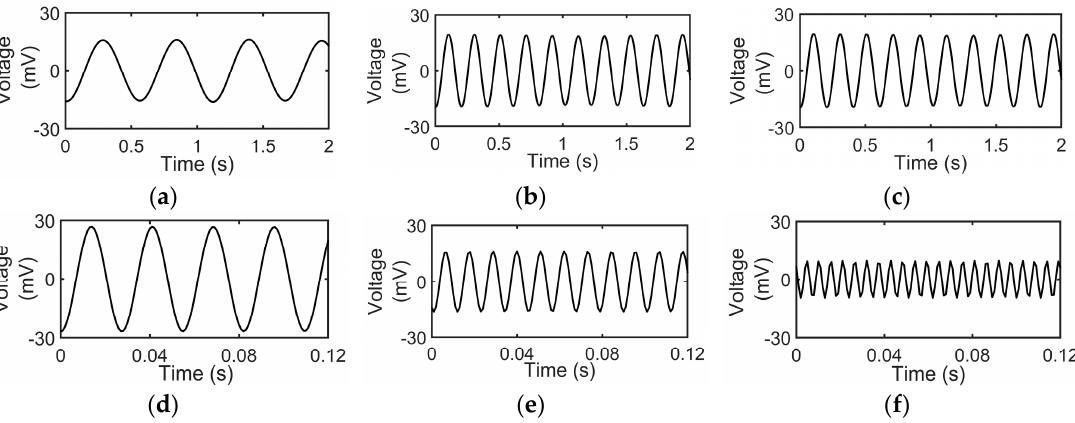
Figure 6. ( a )–( f ) Sensor voltage output to mini shaker amplitude perturbations at frequencies of 2 Hz, 5 Hz, 10 Hz, 40 Hz, 90 Hz and 180 Hz respectively.